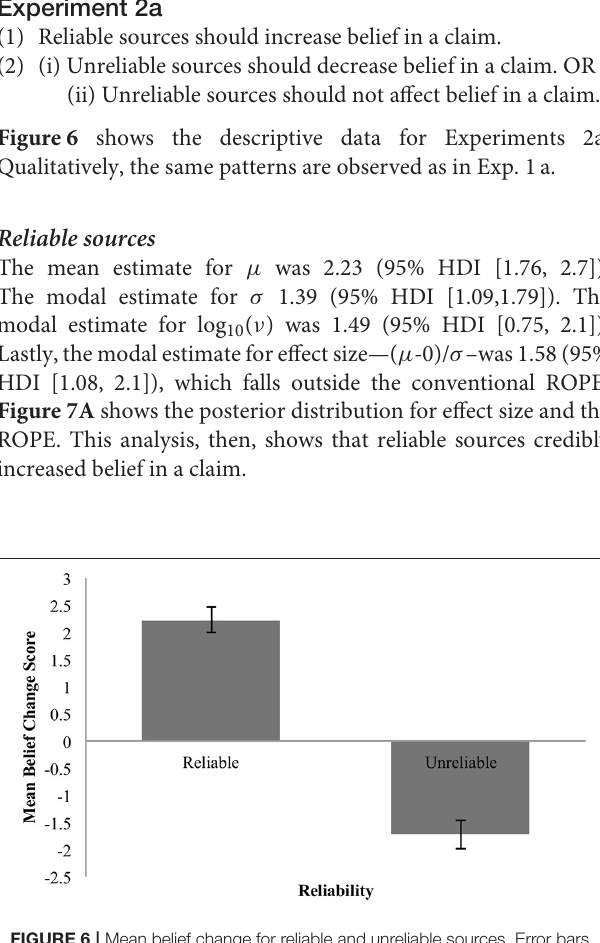
Frontiers in Psychology |